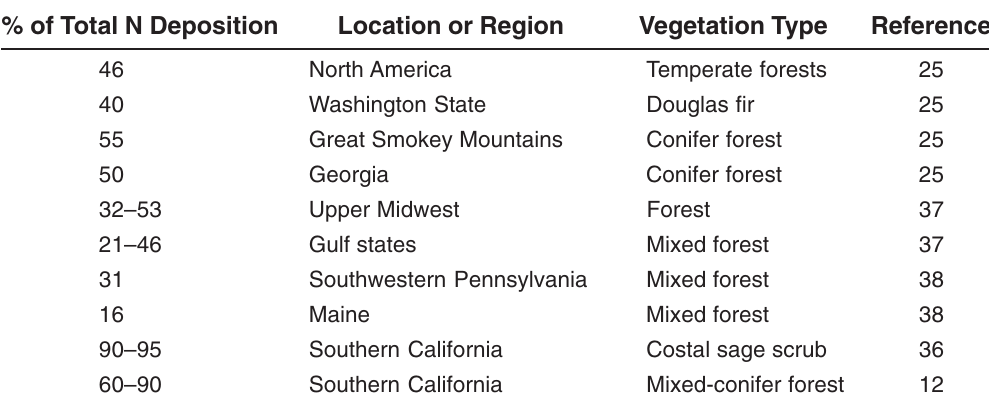
Estimated Percentage of Total Deposited N Due to Dry